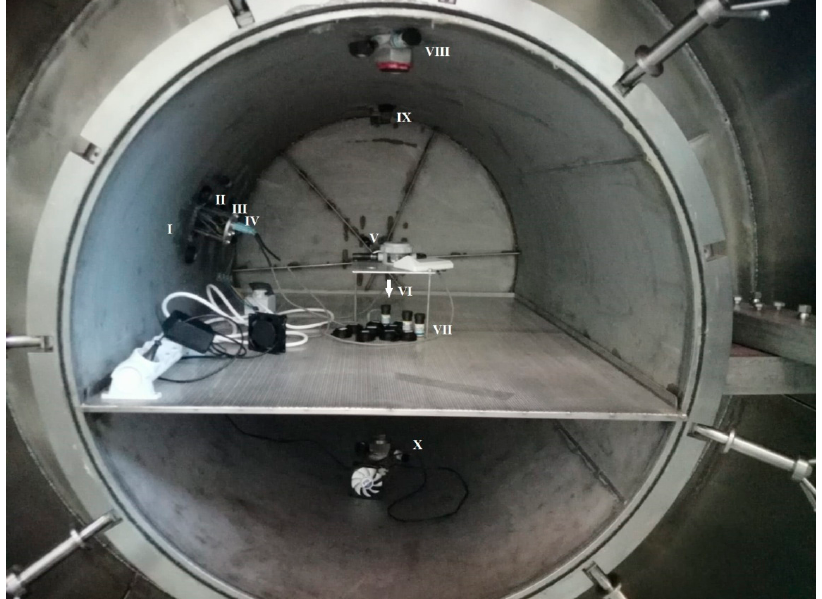
Figure 8. Experimental arrangement of the TASTRAK and RADOSYS nuclear track detectors (I–X) inside the radon chamber (small black disks and cylinders, respectively): close to the radon injection pipe (I–IV), at the bottom plate and in the center of the chamber (V and VI–VII, respectively), near the two upper pipes (VIII–IX) and near the bottom pipe (X).